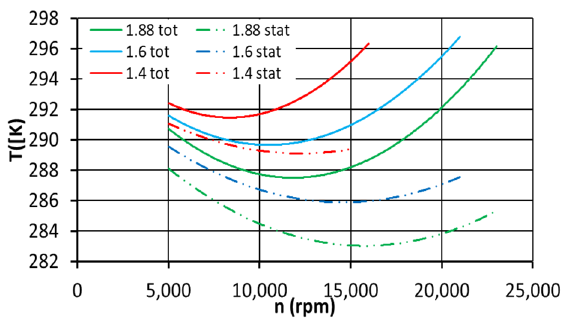
Figure 16. Total and static temperature at the outlet from